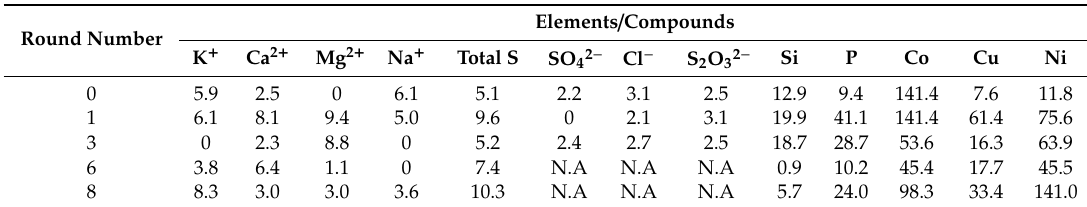
Table 2. The reproducibility, expressed by the coe ffi cient of variation (%), of the dissolution with RW in terms of water